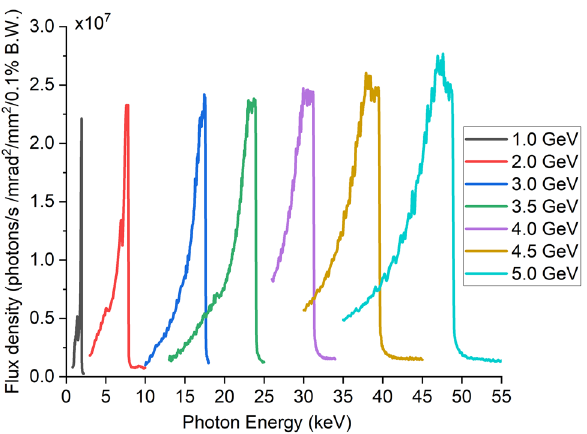
Figure 6. Radiation flux density as the function of radiation energy at different electron beam energies.